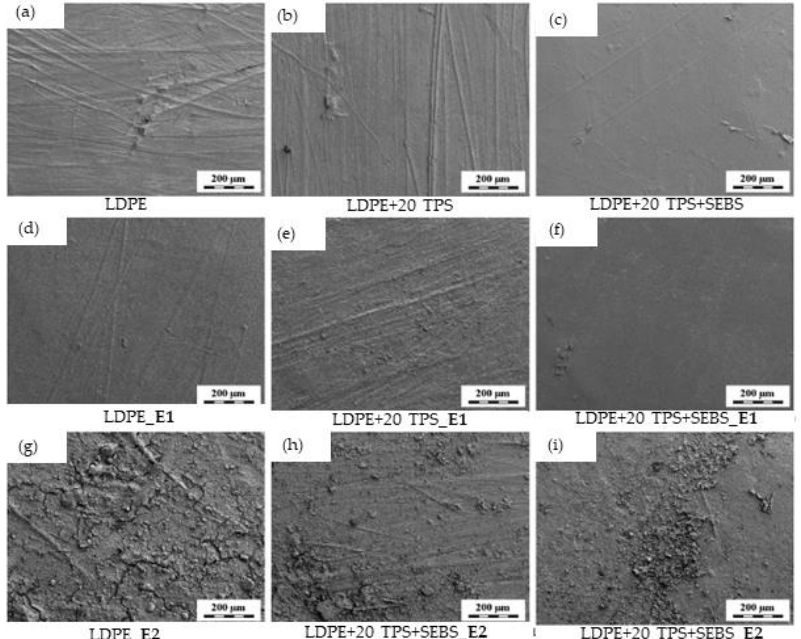
Figure 7. SEM micrographs showing surface of LDPE, LDPE+20 TPS, and LDPE+20 TPS+SEBS before ( a – c ) and after degradation in experiments E1 ( d – f ) and in experiments E2 ( g – i ).